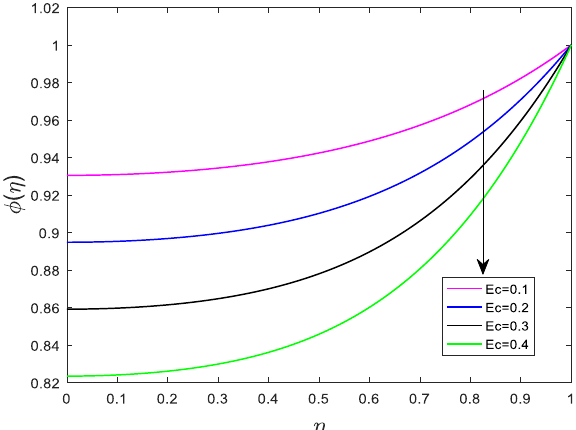
Figure 25: Effect of Pr on ϕ ( η ) for fixed S = N t = Ec = Kr = 0.1, Ha = N = β = Ω = Ω = 0.5 and Sc = T C b